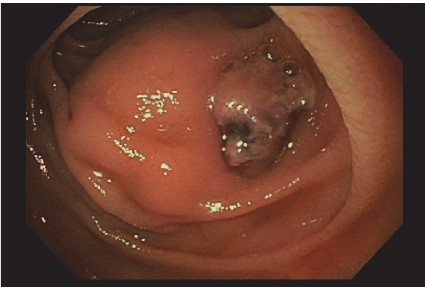
Figure1:EGDshowingalargepulsatingbulgeinthesecondportion of the duodenum with an adjacent 15mm ulcer.